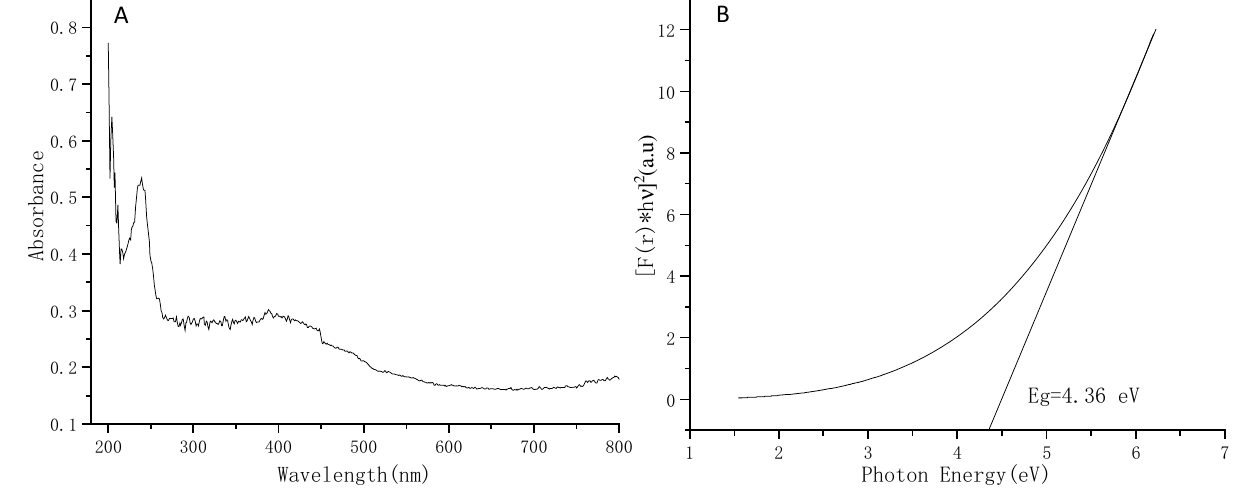
Figure 4. UV–Vis spectrum ( A ) and band gap plot ( B ) of the bacterial PbS nanoparticles.